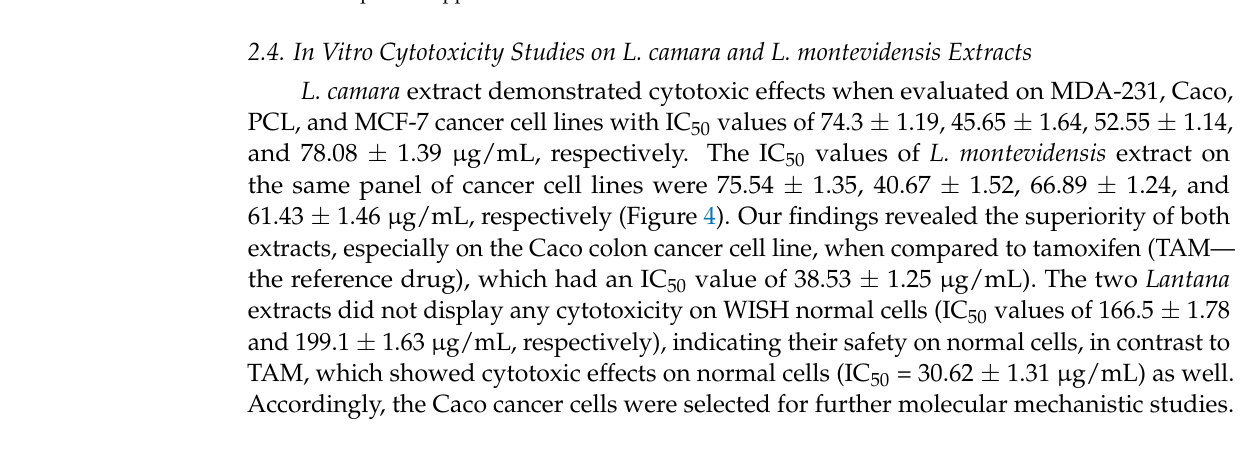
Figure 5. Morphological features of apoptosis in Caco cells treated with L. camara and L. monteviden- sis extracts (at their IC 50 concentrations) after 48 h. 2.4.2. Analysis of the Cell Cycle Cell cycle arrest occurs when the PI3K/Akt protein kinases are inhibited. The activa- tion of GSK-3 β and the blockade of the cyclin D1 signaling pathway reduces the prolifer- ation and metastasis of the Caco cancer cell line. When compared with the untreated cells,